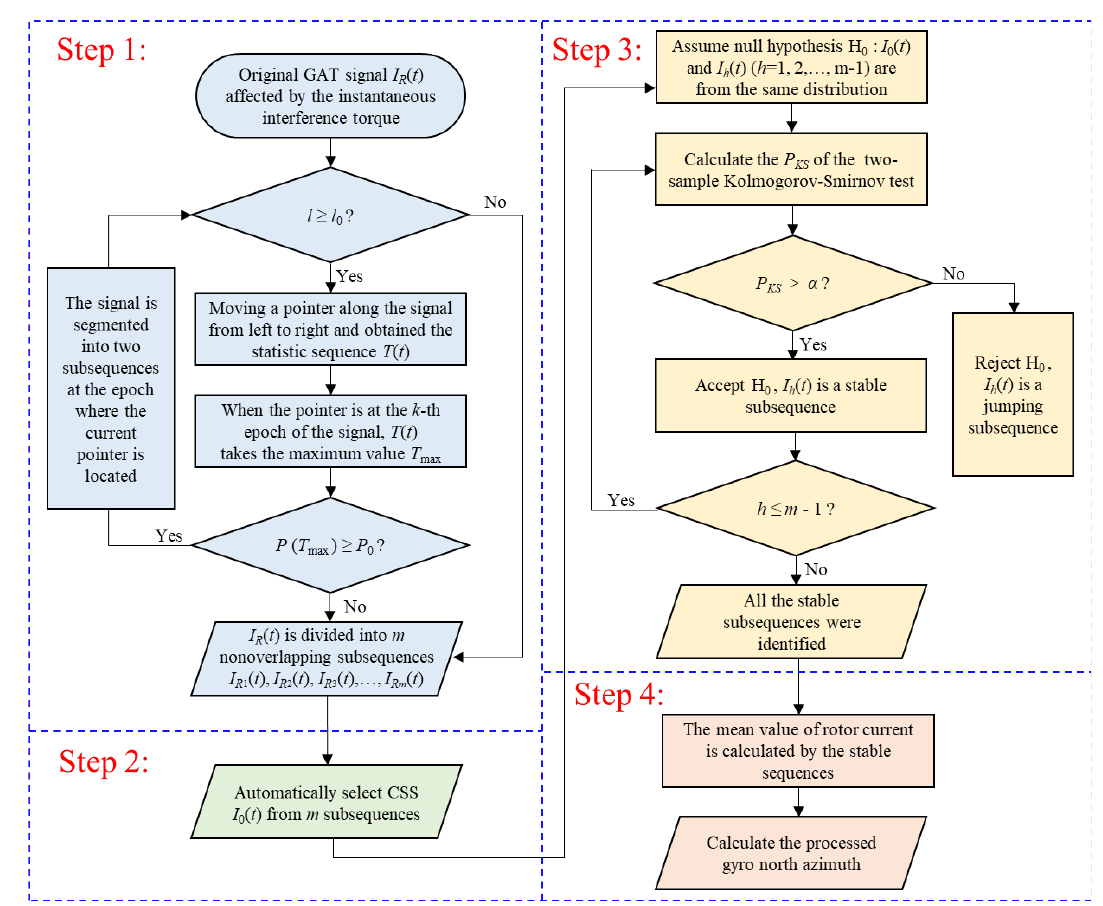
Figure 1. Flow chart of the HSA-KS